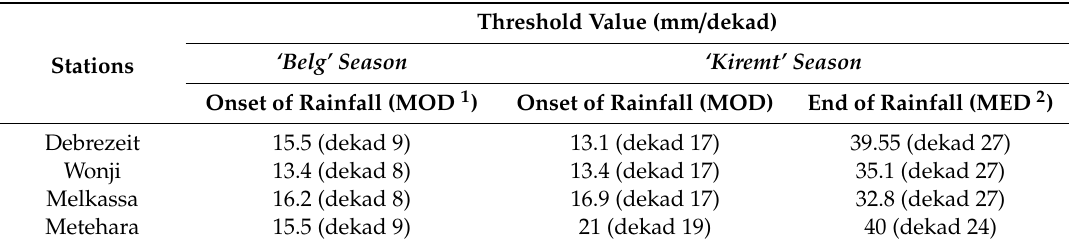
Table 1. Threshold value based on dekadal crop water requirement in different seasons. Stations